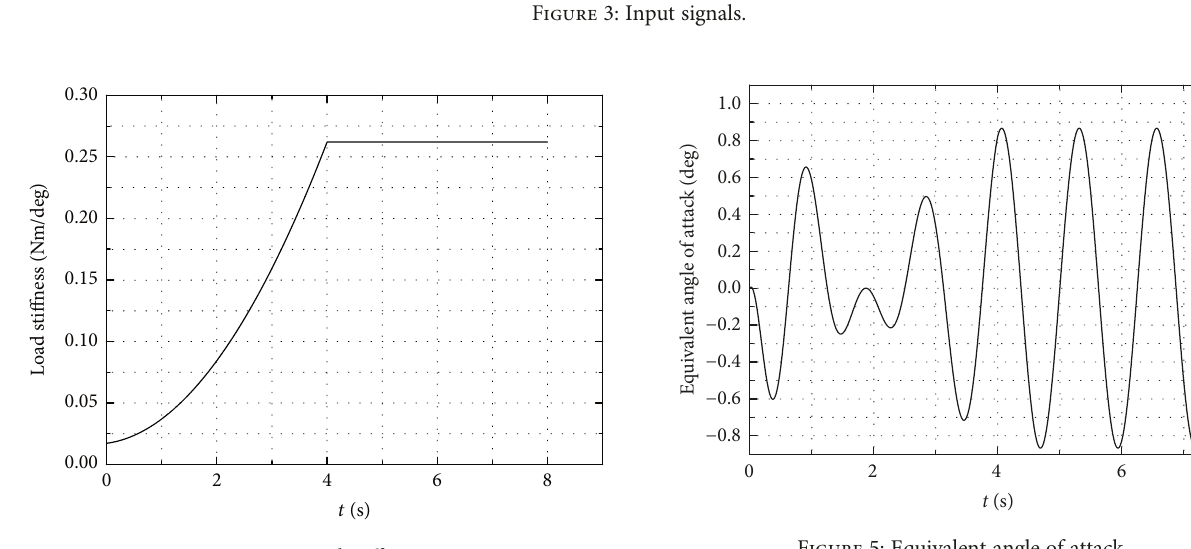
Figure 4: Load sti ff ness. Figure 5: Equivalent angle of